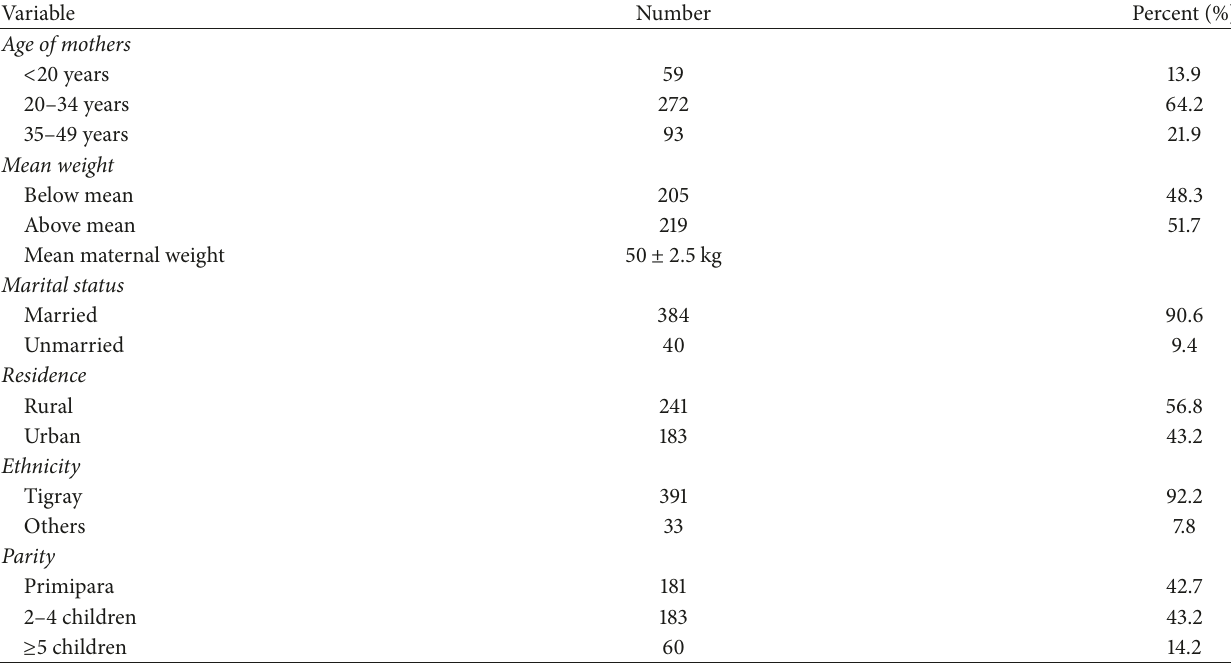
Table 1: Maternal sociodemographic characteristics of the